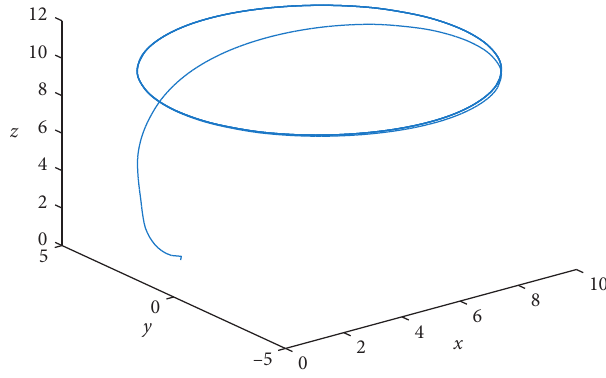
Figure 5: 3-D space state tracking result.